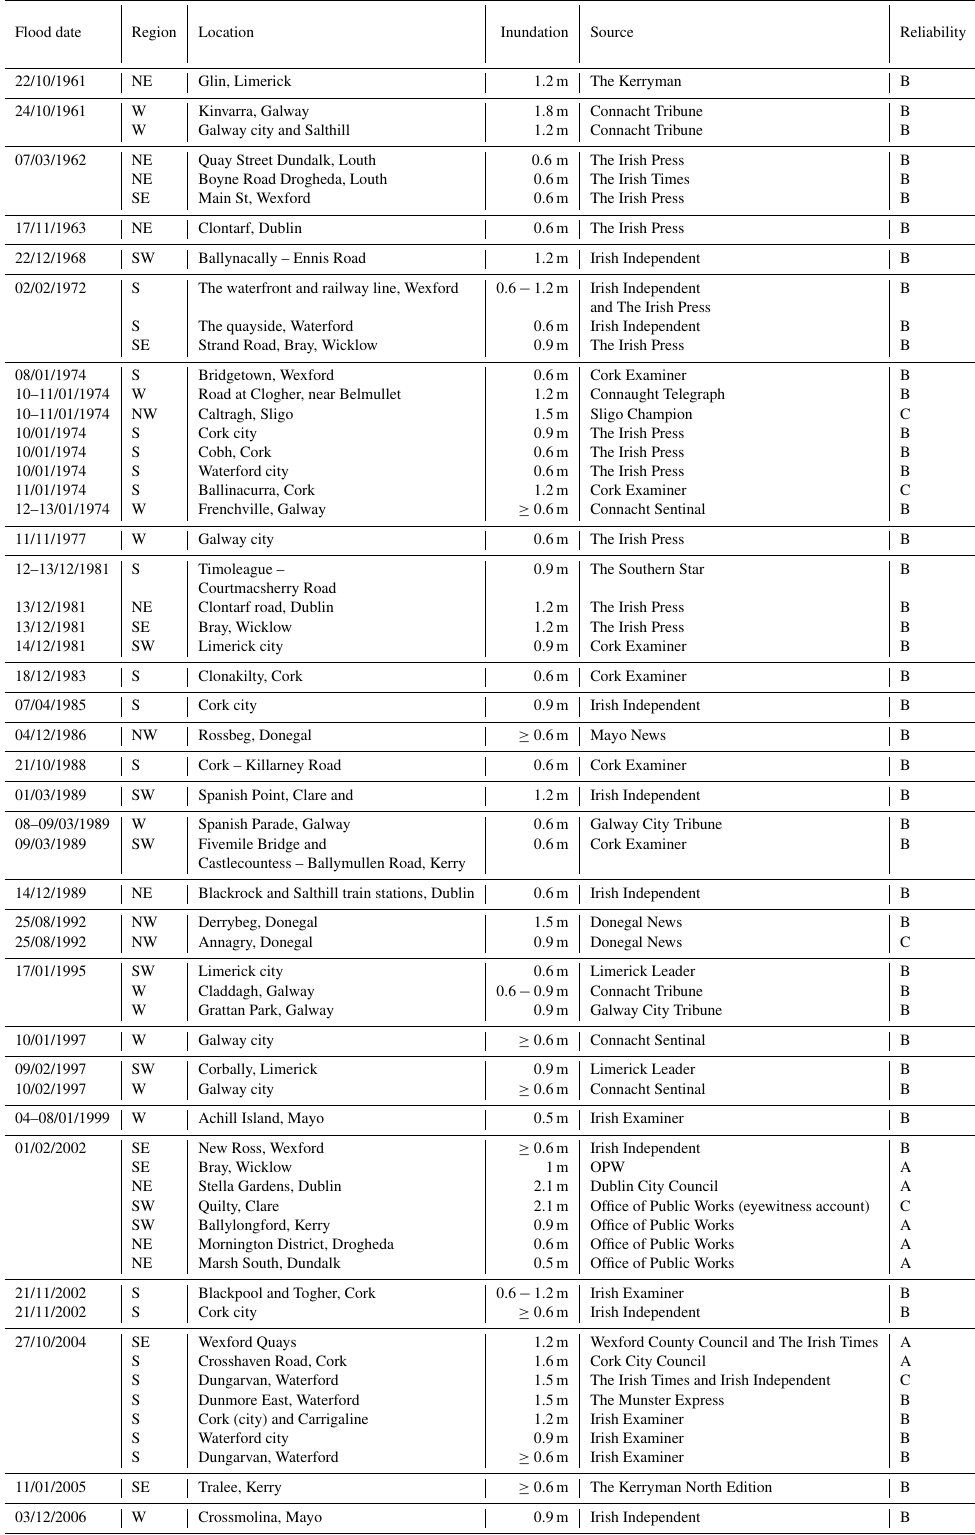
Table 3. Coastal flooding in excess of 0.5m: 1961–2005 in the north-east (NE), south-east (SE), south (S), south-west (SW), west (W), north-west (NW). The reliability of sources are labelled from A to C, where A indicates an official technical report, B indicates a report in a newspaper article, and C is an eyewitness account in a newspaper article. Note that dates are given in the format